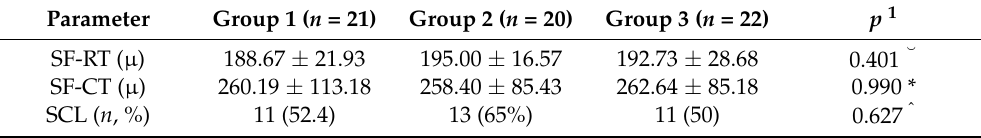
Table 2. Subfoveal retinal and choroidal thickness and presence of suprachoroidal layer.